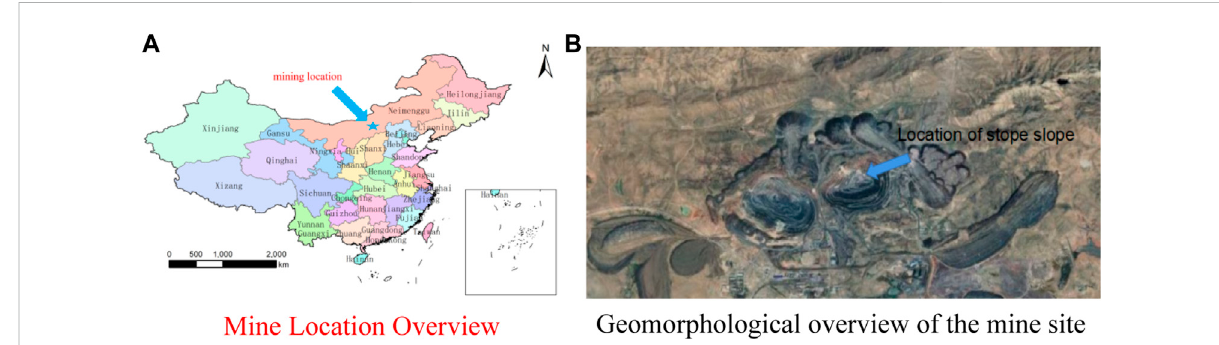
FIGURE 1 Schematic diagram of the location of the mine.